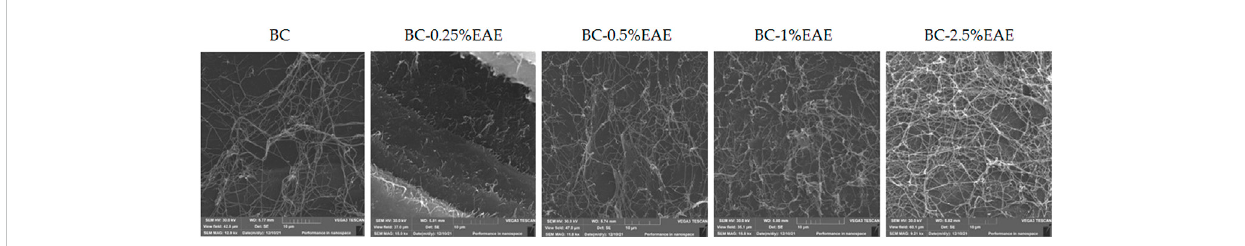
FIGURE 4 The SEM micrographs of BC, and BC containing EAE at different concentrations on a scale of 10 µm.